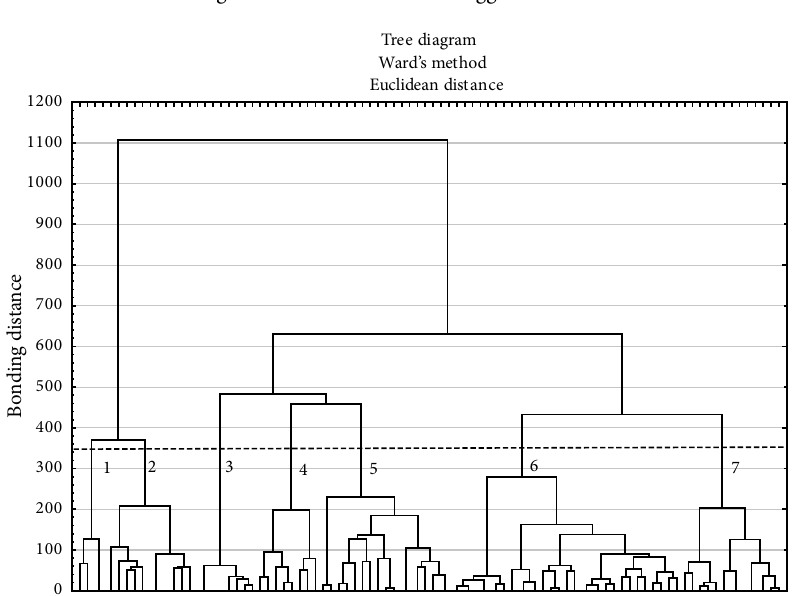
Fig. 5. Diagram of clusters of future oriented technology